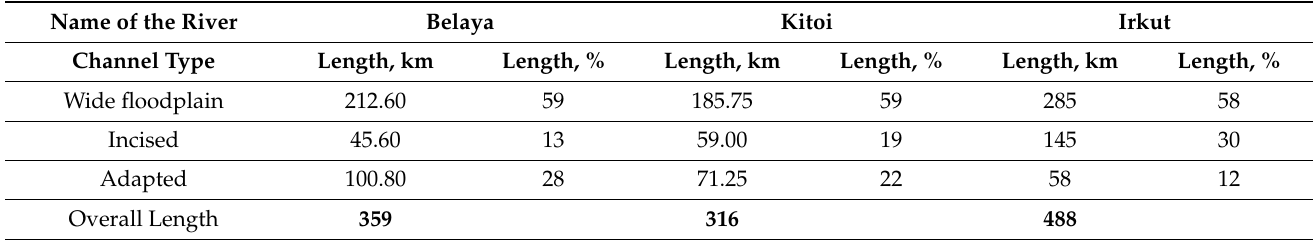
Table 2. Distribution of morphodynamic types of channels in the area under